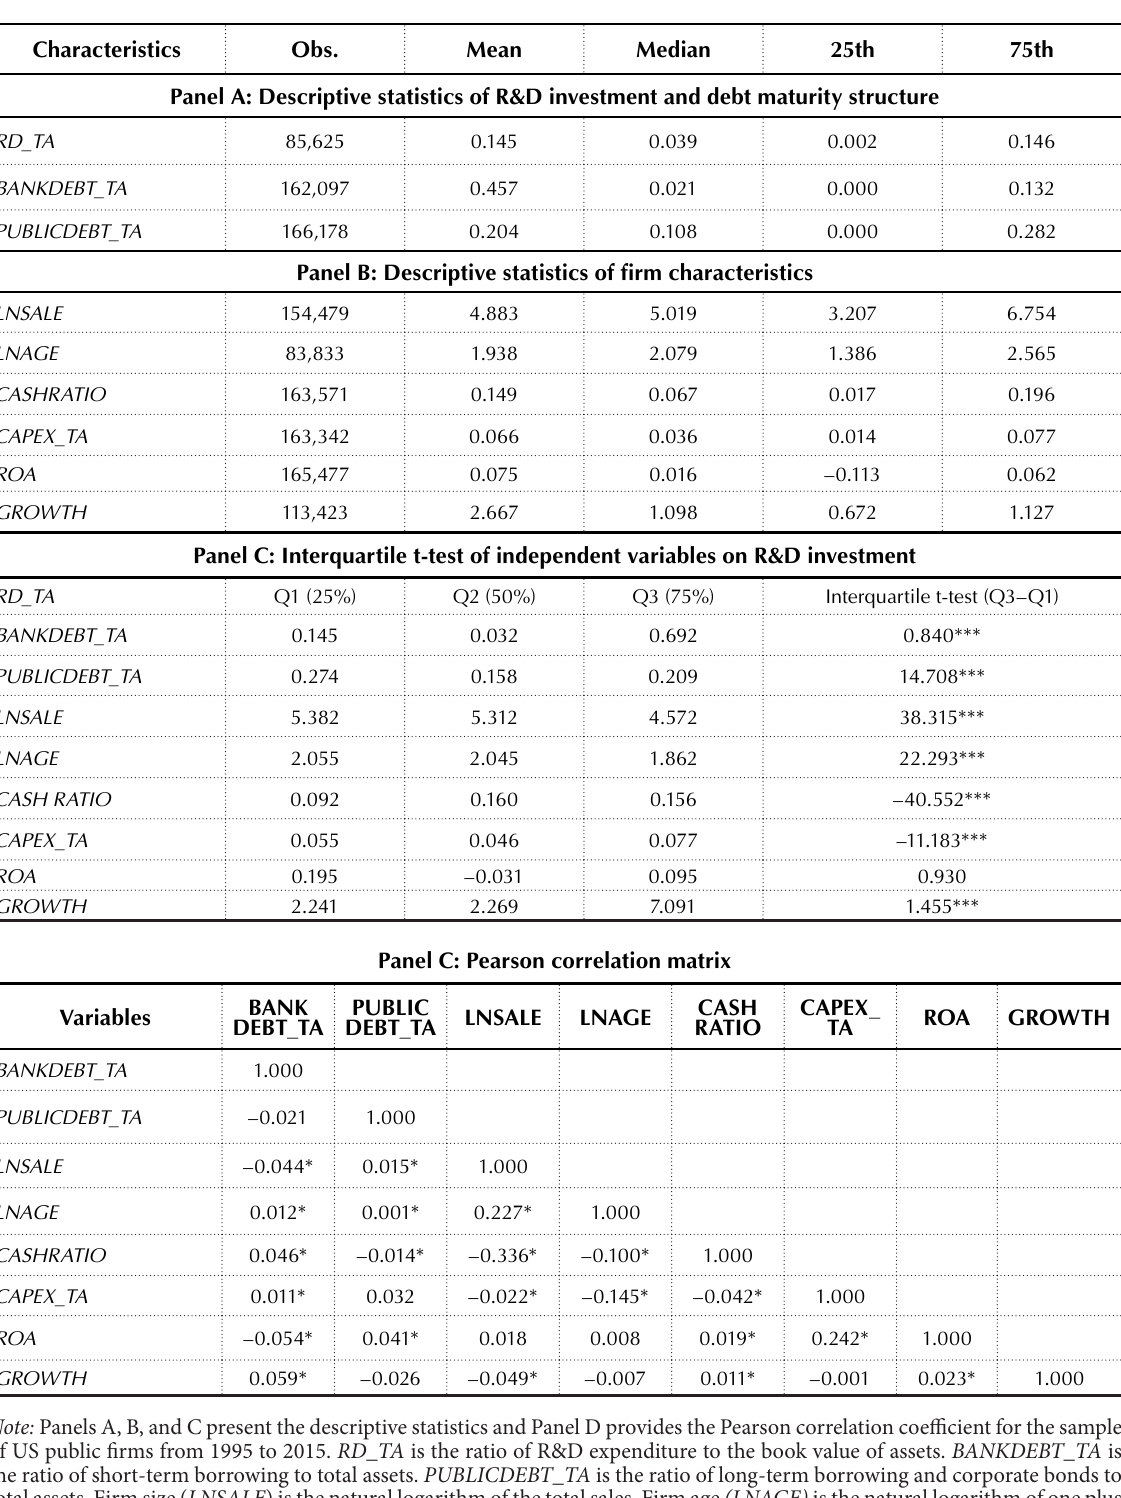
Table 1. Descriptive statistics of firm characteristics and correlations among the predictors of R&D